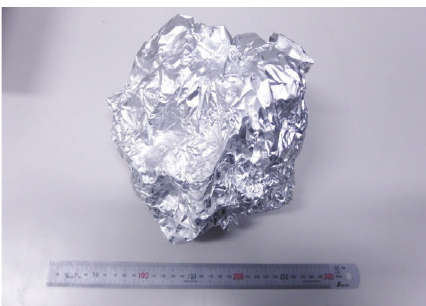
Figure 17: Example of a fabricated complex target.